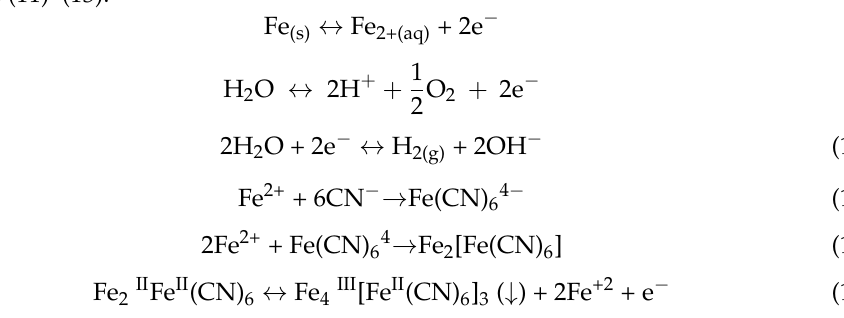
Figure 5. Removal of cyanide and heavy metal by EC process. ( a ) Fe-SS; ( b ) Fe-Al. The process of removing heavy metals and cyanide from the solution using EC technique is shown in Equations (8)–(12). According to Equations (8)–(10), by starting reactions and electrical operations, the iron anode begins to oxidize, and the cathode begins to shrink. Ferrous ions react with cyanide ions to form cyanogenite complexes according to Equations (11) – (13).